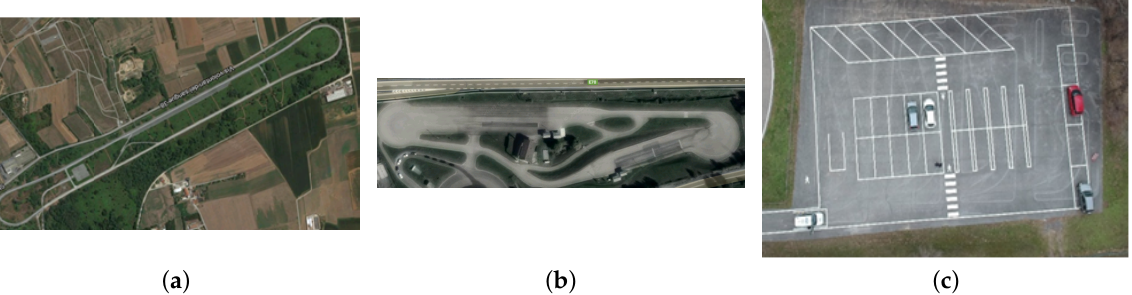
Figure 13. Private facilities adopted by the team of Automated Driving Technologies in Marelli to exercise their vehicles. ( a ) reports the highway installation, ( b ) the urban complex, and ( c ) the parking center.